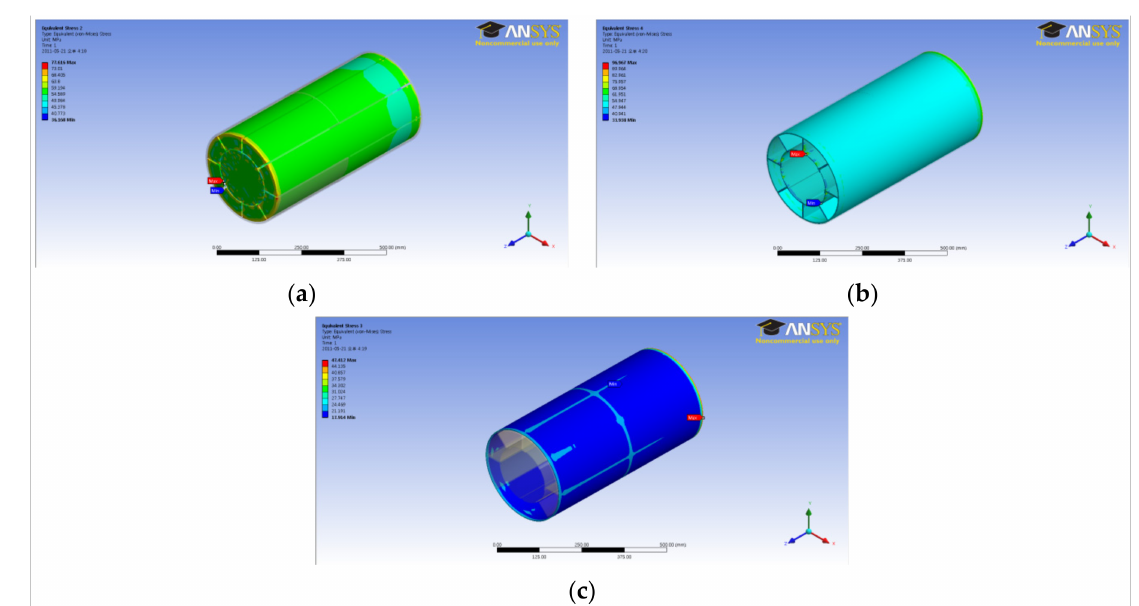
Figure 21. FEA of the hybrid − CFFT: ( a ) Concrete, ( b ) PFRP, and ( c ) FFRP.